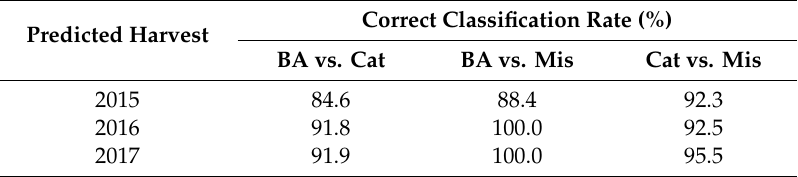
Figure 2. ROC curves related to the binary classification models ( a ) BA vs. Cat; ( b ) BA vs. Mis; ( c ) Cat vs. Mis. Table 1. PLS-DA prediction results expressed as correct classification rates (FT-MIR